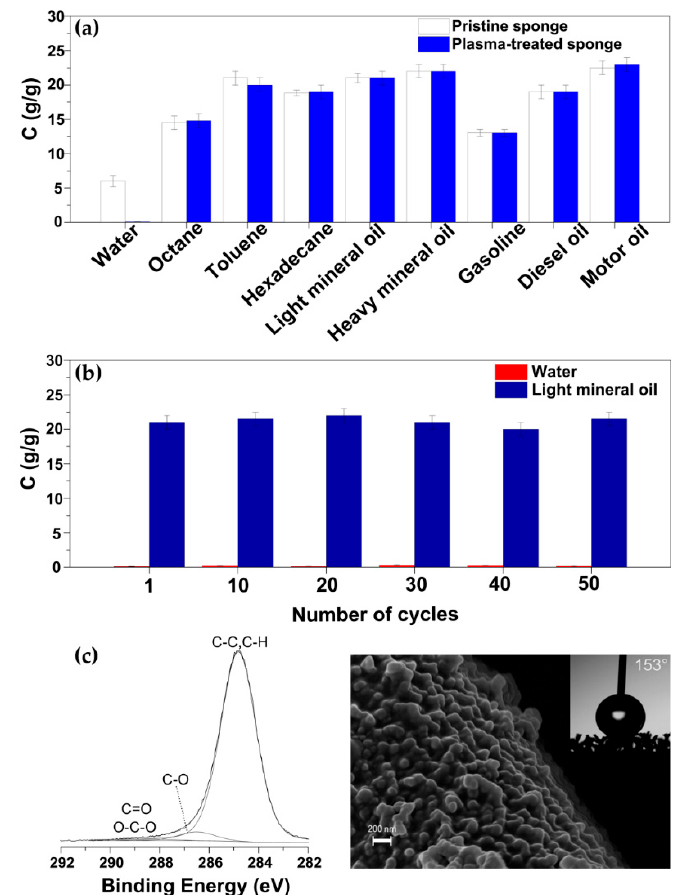
Figure 6. ( a ) Absorption capacity of the pristine and plasma-treated PU foams for water, various hydrocabon solvents and oils, gasoline, diesel oil and motor oil. The PU foam was modified by a two-step plasma process consisting of an etching/nanotexturing step (t e/n = 10 min) followed by a thin-film deposition step (t d = 10 min). ( b ) Absorption capacity of the plasma-treated foam for water and light mineral oil over 50 adsorption–desorption cycles. ( c ) Results from the characterization of the plasma-treated foam after 50 adsorption–desorption cycles using water and octane as test liquids: XPS C 1s signal, representative SEM image and photograph of a water droplet placed on the sample for WCA